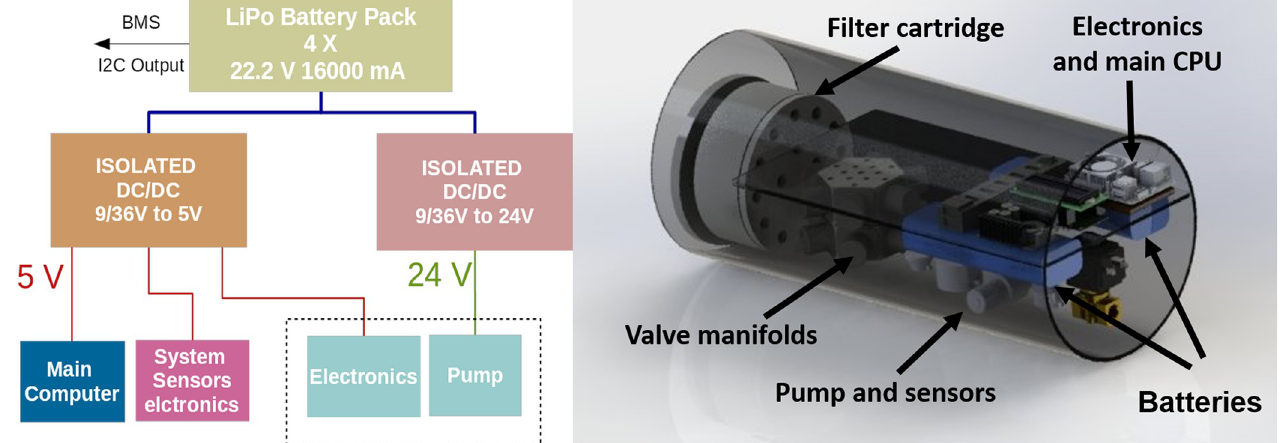
Fig 8. Field autonomous biosampler prototype components (left) and CAD model (right). The components are all mounted inside a cylinder in vacuum.